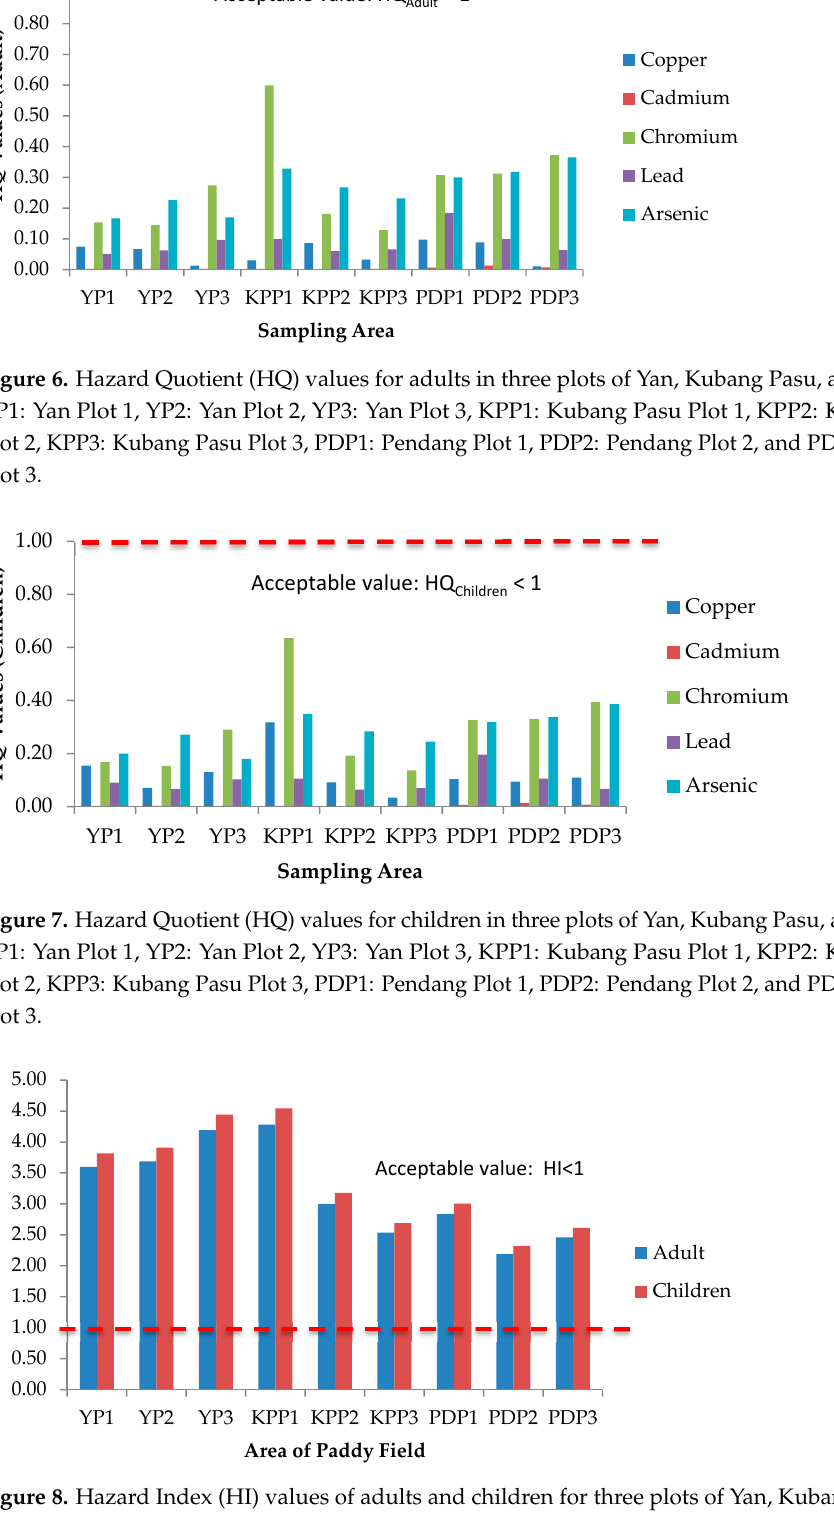
Figure 8. Hazard Index (HI) values of adults and children for three plots of Yan, Kubang Pasu, and Pendang. YP1: Yan Plot 1, YP2: Yan Plot 2, YP3: Yan Plot 3, KPP1: Kubang Pasu Plot 1, KPP2: Kubang Pasu Plot 2, KPP3: Kubang Pasu Plot 3, PDP1: Pendang Plot 1, PDP2: Pendang Plot 2, and PDP3: Pendang Plot 3.